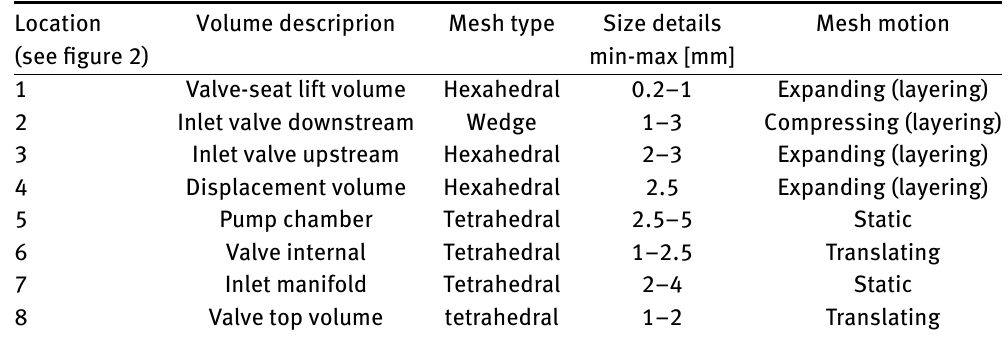
Table 2: Mesh 2 details summar Location Volume descriprion Mesh